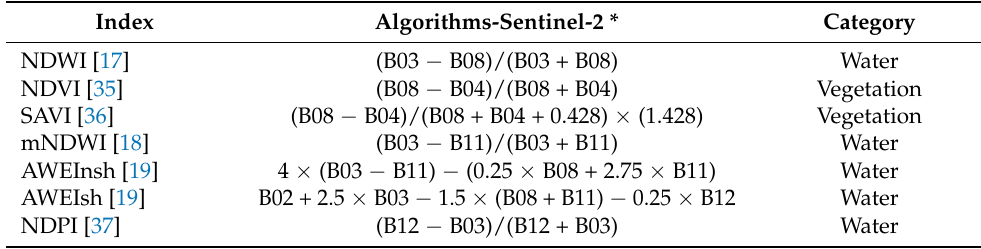
Table 2. Summary of indexes used in the study.